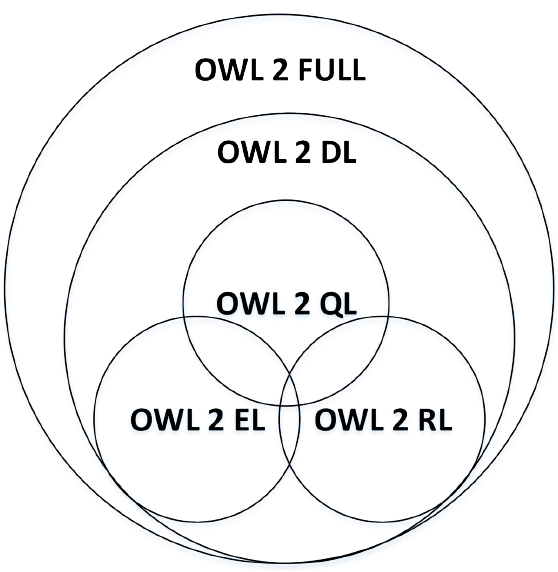
Figure 2. Relationships between sub-languages of OWL